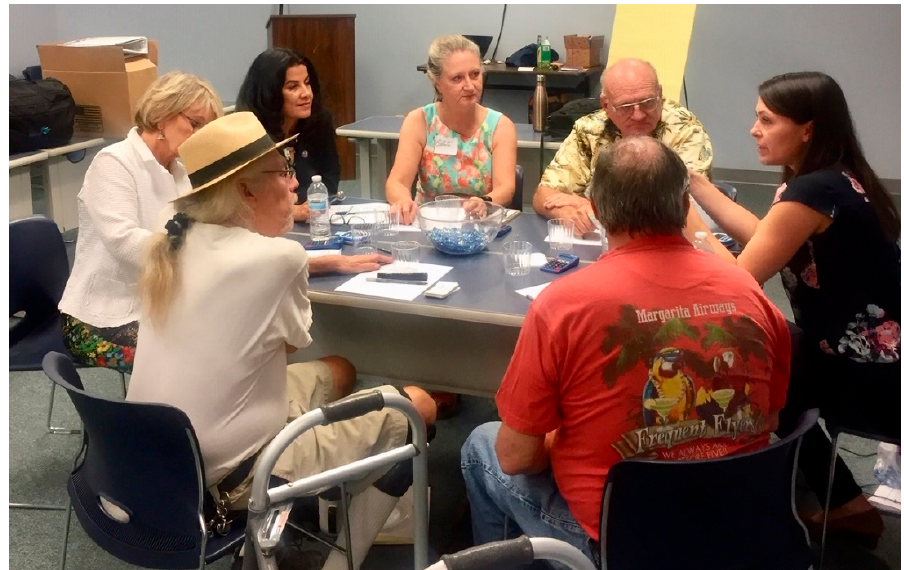
Figure 2. Participants play the Groundwater Management Simulation, with the water “reservoir” on the center of the table, at a training in El Centro, California. Permission to use this photo has been obtained from all pictured individuals.